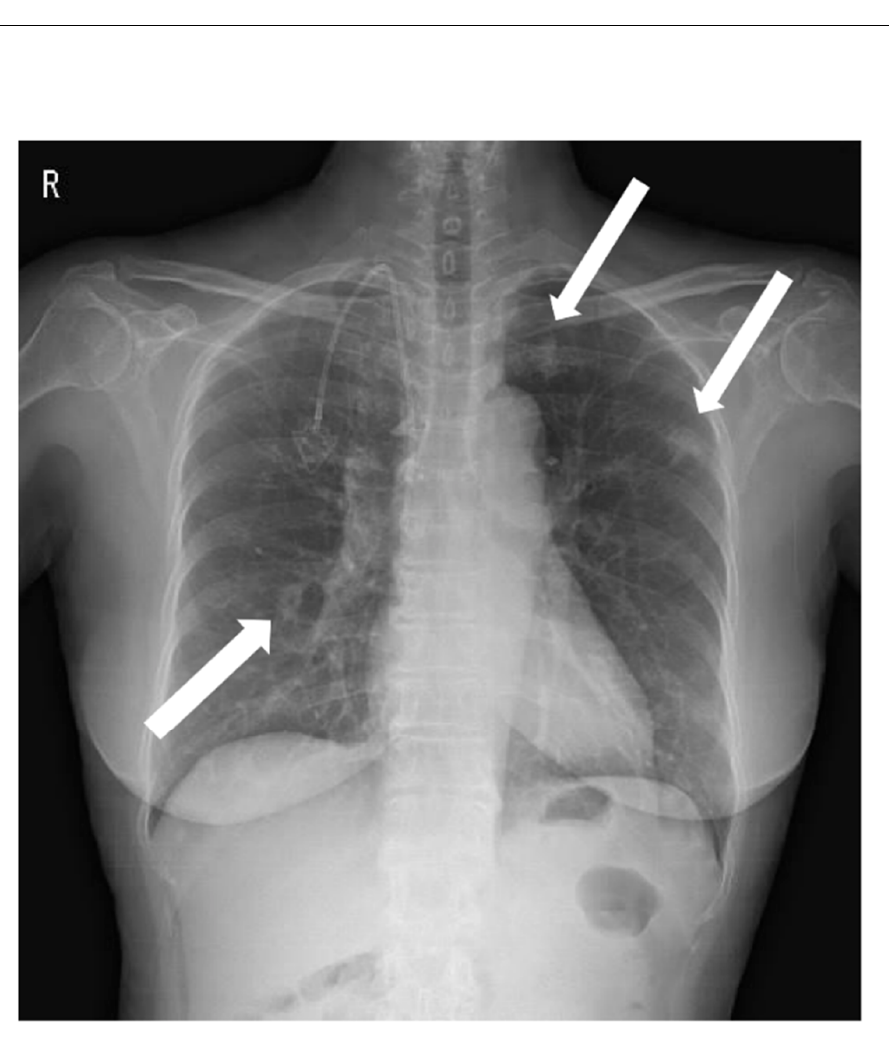
Figure 1. A chest X-ray was performed at admission, showing scattered nodular opacities in the left lung upper lobe and right lung lower lobe, which indicated a central area of excavation (arrows). 18 F-fluorodeoxyglucose positron emission tomography/computed tomography ( 18 F-FDG PET/CT) has increasingly been used to manage cancers and infections [1–3]. Since FDG uptake is directly representative of glucose metabolism, it can increase in inflammatory cells as well as tumor cells. Long-term indwelling central venous catheters are necessary for treating cancer patients due to chemotherapy. They depend on their central venous catheters daily, which could predispose a significant risk of complications such as catheter-related bloodstream infection (CRBSI) [4–6]. CRBSI can be complicated by metastatic infectious foci associated with a high morbidity and mor- tality rate, which should require prolonged systemic antimicrobial treatment [7]. The significant complication of CRBSI is septic thrombosis, with a prevalence of 15~24% [8,9]. The clinical diagno- sis of septic foci is critical but may be difficult to establish due to the challenge of determining be- tween sterile catheter-related thrombosis and actual septic thrombosis. Additionally, symptoms are often non-specific, and there is a lack of sensitivity to conventional diagnostic imaging techniques. Only a few studies investigated that 18 F-FDG PET/CT can find the infectious foci, demonstrating it as an accurate imaging modality for metastatic foci [10–12]. Here, we would like to report a female patient with a Staphylococcus aureus-implantable venous access catheter infection in which 18 F-FDG PET/CT determined unsuspected septic pulmonary emboli. A 71-year-old female patient with known ovarian cancer visited our hospital to receive the 4th adjuvant chemotherapy. She was treated with total abdominal hysterectomy, bilateral salpingo-oophrectomy and omentectomy 6 months ago. She also had a history of central venous catheterization by the right internal jugular vein approach, terminating at the junction of the superior vena cava and right atrium. The adjuvant chemotherapy was already performed three times as the regimen of Paclitaxel plus Carboplatine after surgery. At admission, she presented no clinical symptoms such as fever, cough, sputum, dyspnea, or chest pain. However, the chest X-ray showed scattered nodular opacities in the left lung upper lobe and right lung lower lobe, suspicious of metastatic nodules (Figure 1). Her blood test showed unexplained leukocytosis (12.58 × 10 3 / μ L), elevated D-dimer (9.46 mg/L), and a tumor